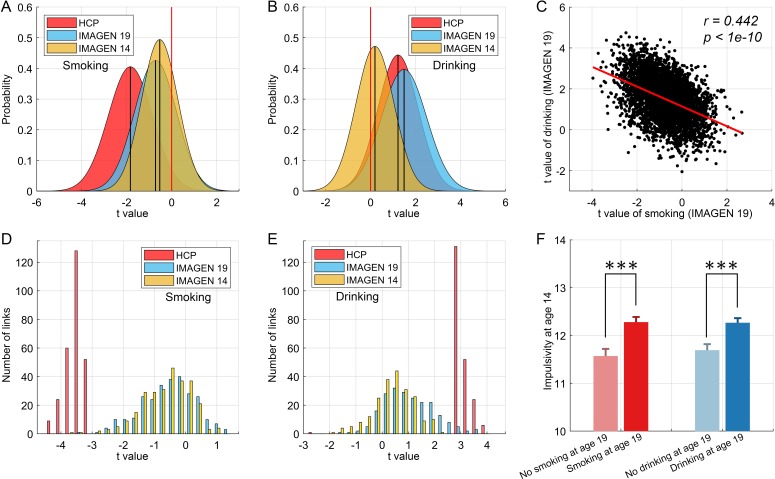
Cross-validation and causality analysis using the IMAGEN dataset.(A) The distribution of t values of all brain links in the three datasets (i.e. HCP, and IMAGEN at age 14 and 19) for smoking. (B) The same for the drinking group. The overall change pattern identified in the HCP dataset, that is decreased FC in smoking and increased FC in drinking, is consistent in the IMAGEN dataset. This is useful cross-validation. (C) The correlation between the t values of the contrasts for the drinking and smoking groups involving all links in the brain. (D) The distribution of t values of the significant links identified in the HCP dataset for all three datasets (i.e. HCP, IMAGEN at age 14 and 19) for smoking. (E) The same for the drinking group. (F) The results for impulsivity at age 14 from the IMAGEN dataset. This shows that the 14 year olds who will smoke at age 19 (n = 421) have higher impulsivity than those who will not smoke at 19 (n = 184) (t = −3.72, p=2.20 × 10−4). The 14 year olds who will drink at age 19 (n = 527) have higher impulsivity than those who will not drink at 19 (n = 298) (t = −3.67, p=2.60 × 10−4). ***p<0.001.